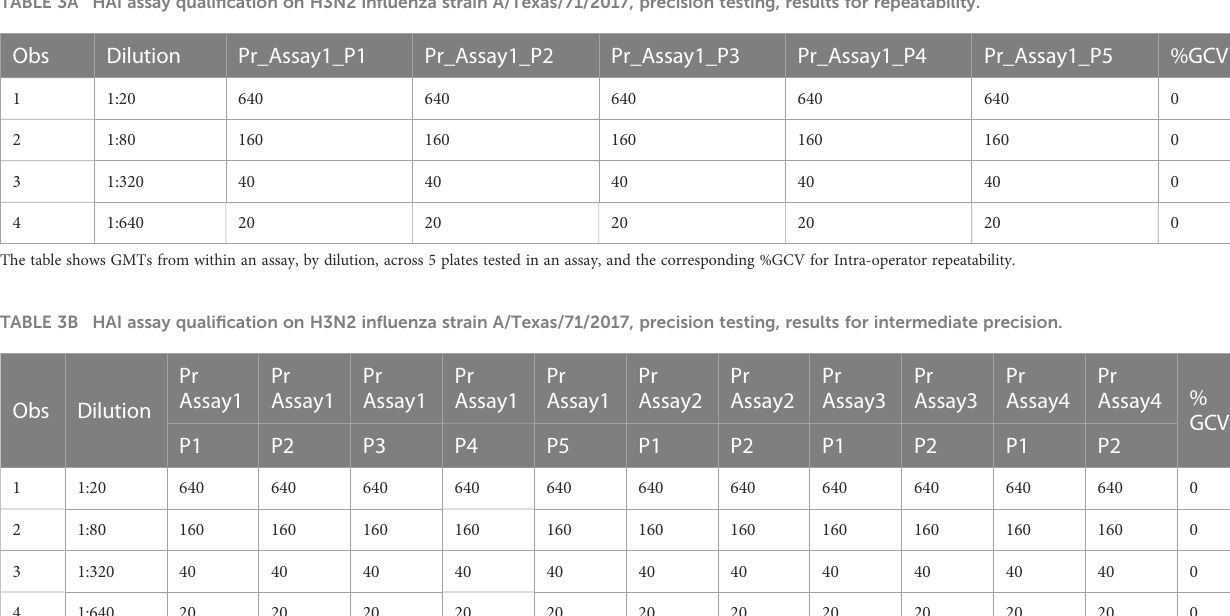
TABLE 3A HAI assay quali fi cation on H3N2 in fl uenza strain A/Texas/71/2017, precision testing, results for repeatability.